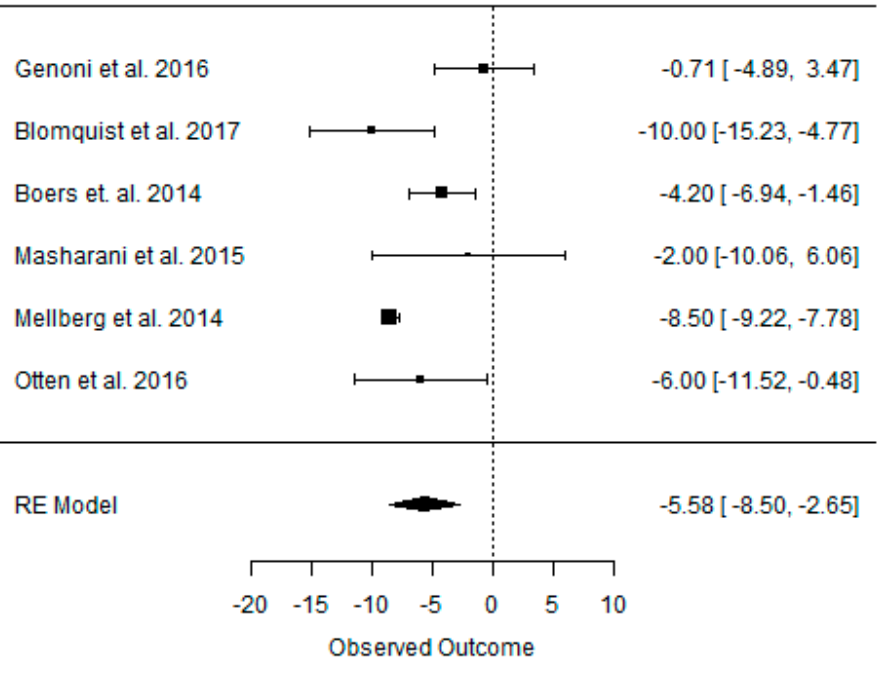
Figure A37. Forest plot of the effect of a PDs on DBP in the short term (weighted mean difference).